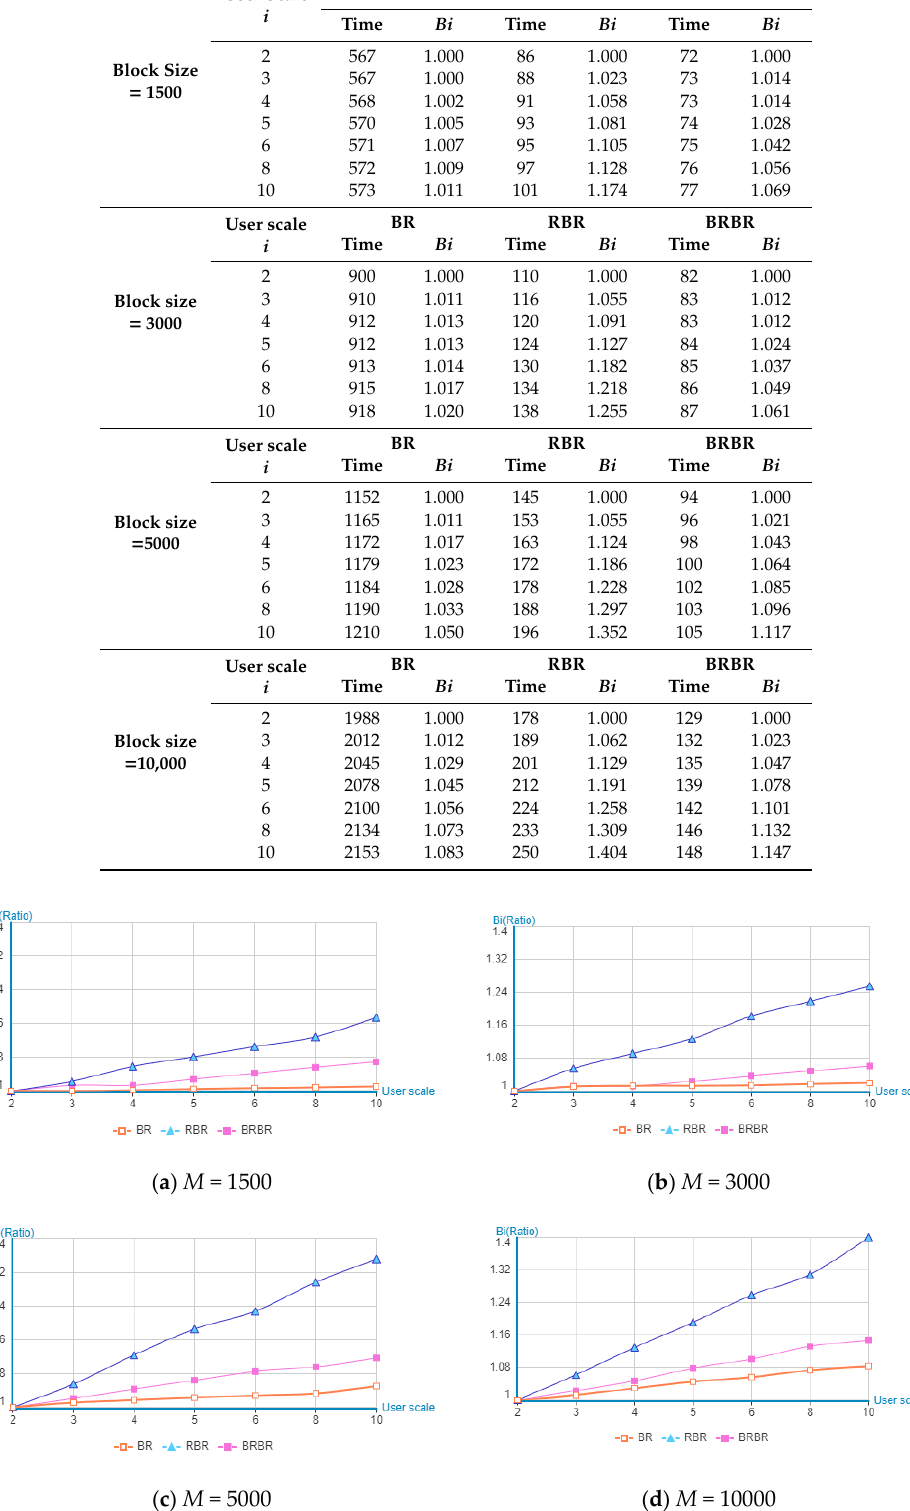
Figure 15. The increasing trend of retrieval time of three retrieval algorithms in different user scale and block number (M is the module of block gauge).